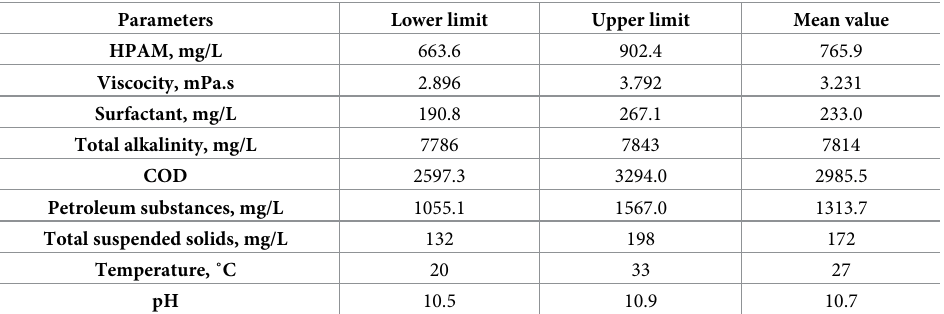
Table 1. Typical ranges for the chemical composition and related parameters in wastewater influent obtained from the ASP flooding water treatment station (Daqing, China).